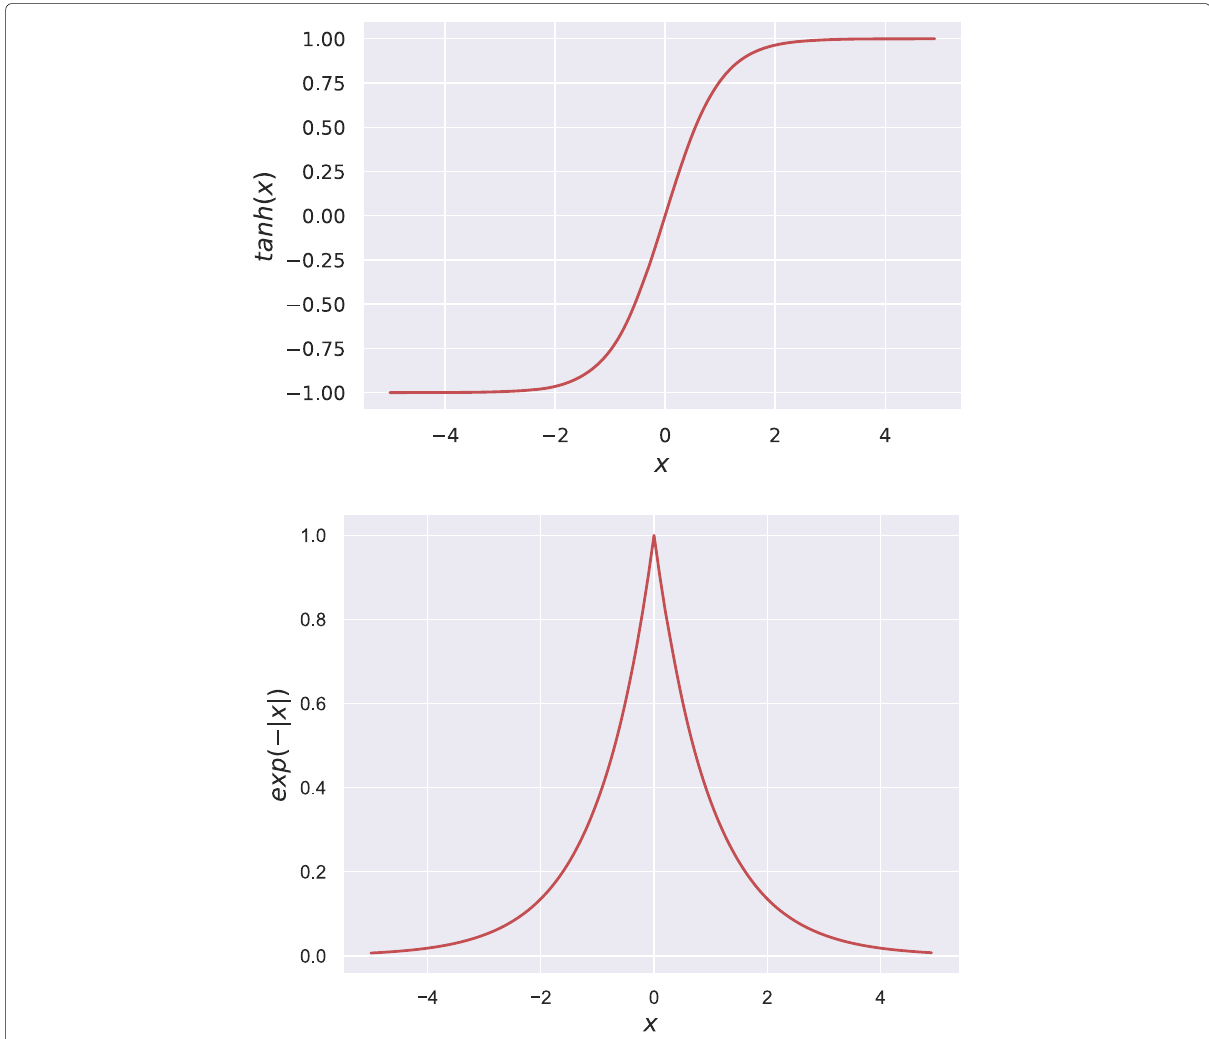
Fig. 3 Top: Hyperbolic tangent function. Bottom: Exponentially monotone function